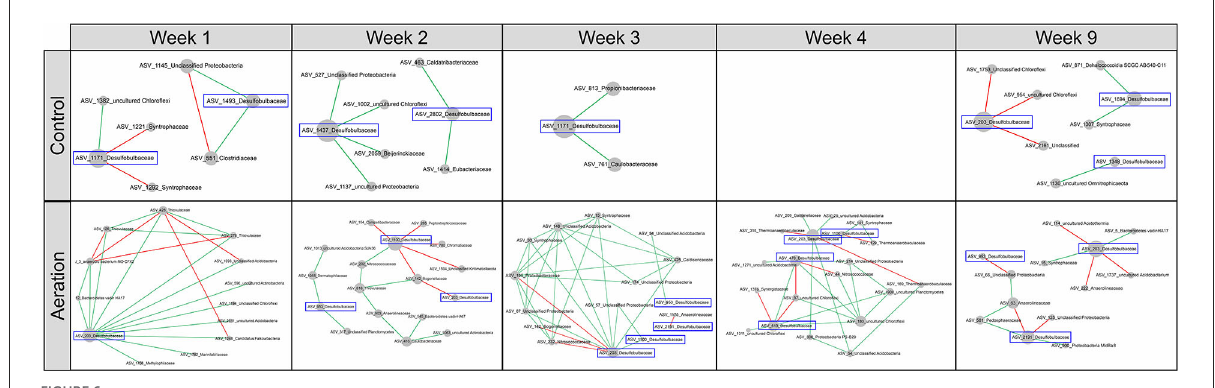
FIGURE6 Subnetworks revealing temporal changes in the interactions among nodes of Desulfobulbaceae and direct-linking nodes of other families from Week 1 to 9 under aeration or not. Desulfobulbaceae was not present in the control Week 4 pMEN. Node size was proportional to node degree in subnetworks. A link represented a significant Spearman’s Rho rank correlation between two nodes, green for positive and red for negative